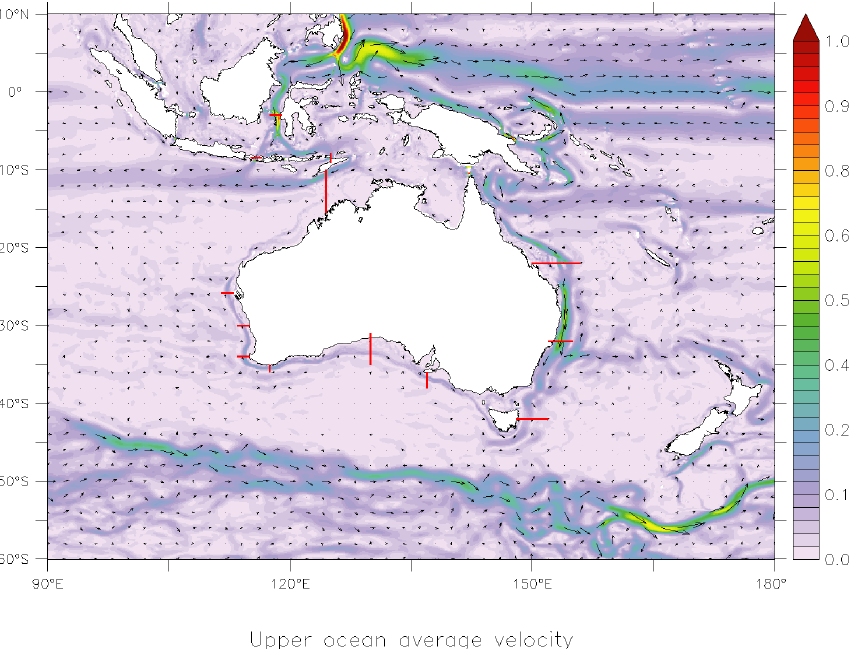
Figure 12. Average currents around Australia, averaged over 0–250m, from 2000 to 2009, with red lines indicating locations of transects listed in Table